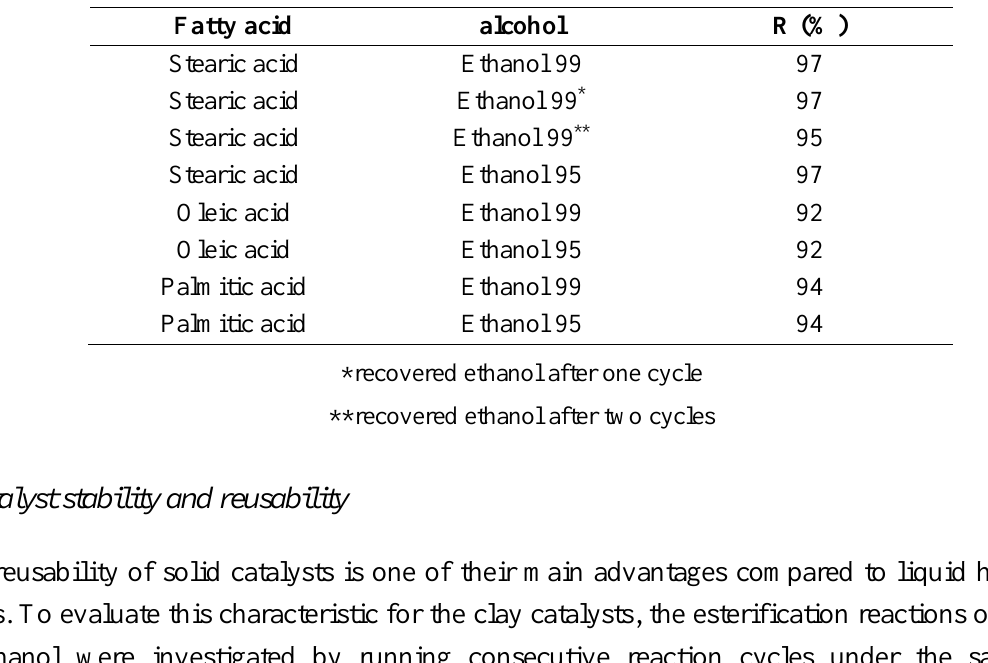
Table 3. Effect of water contained in ethanol: esterification of stearic, oleic, and palmitic acid with ethanol 99 and ethanol 95.